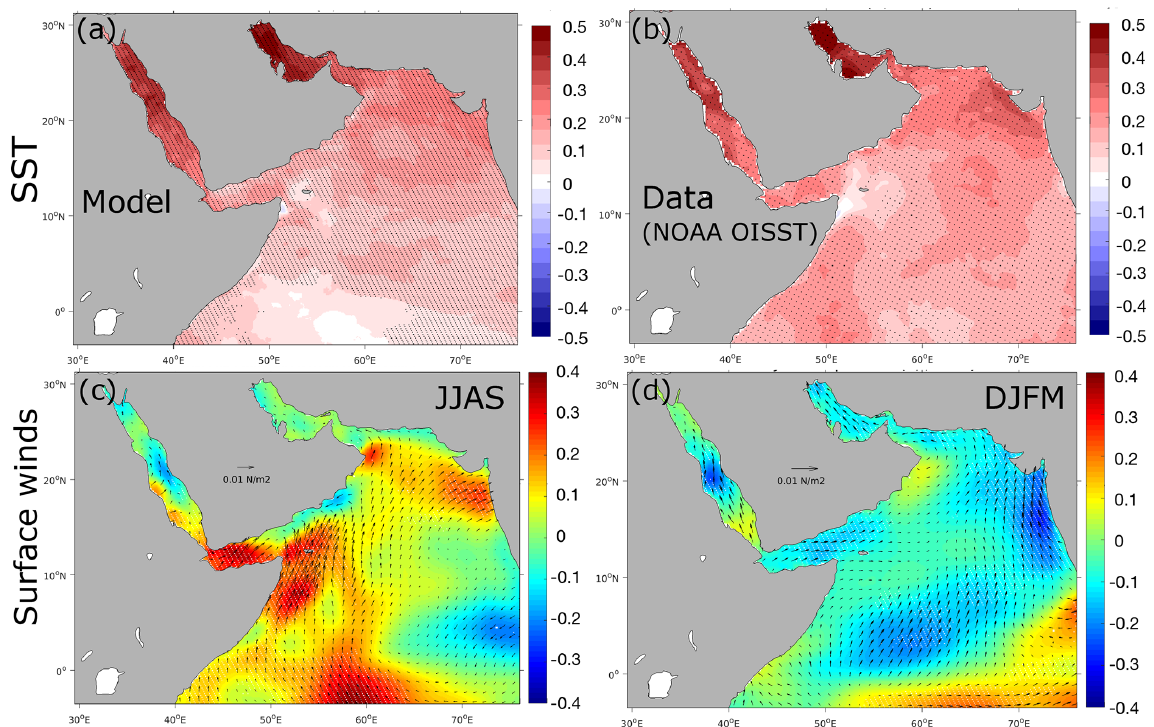
Figure 2. Warming and surface wind trends. (a, b) Linear trends in sea surface temperature (in degrees Celsius per decade) as simulated by the model (a) and from the NOAA OISST data product (b) . (c, d) Trends in ERA-Interim surface winds in summer (c) and winter (d) . Color shading indicates trends in wind speed (in ms − 1 per decade), whereas arrows show trends in wind stress vector. Statistically significant trends at the 95% confidence interval following a Mann–Kendall (MK) test are represented by